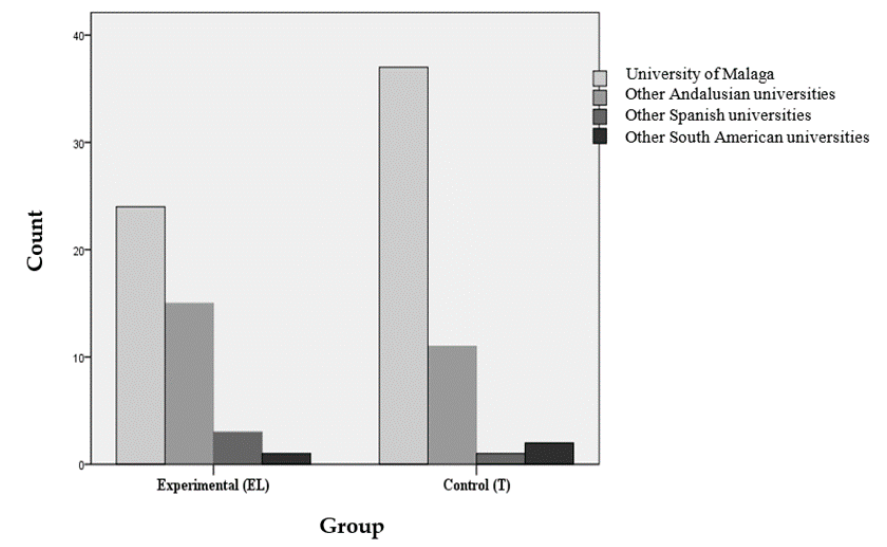
Figure 2. Alumni alma mater.